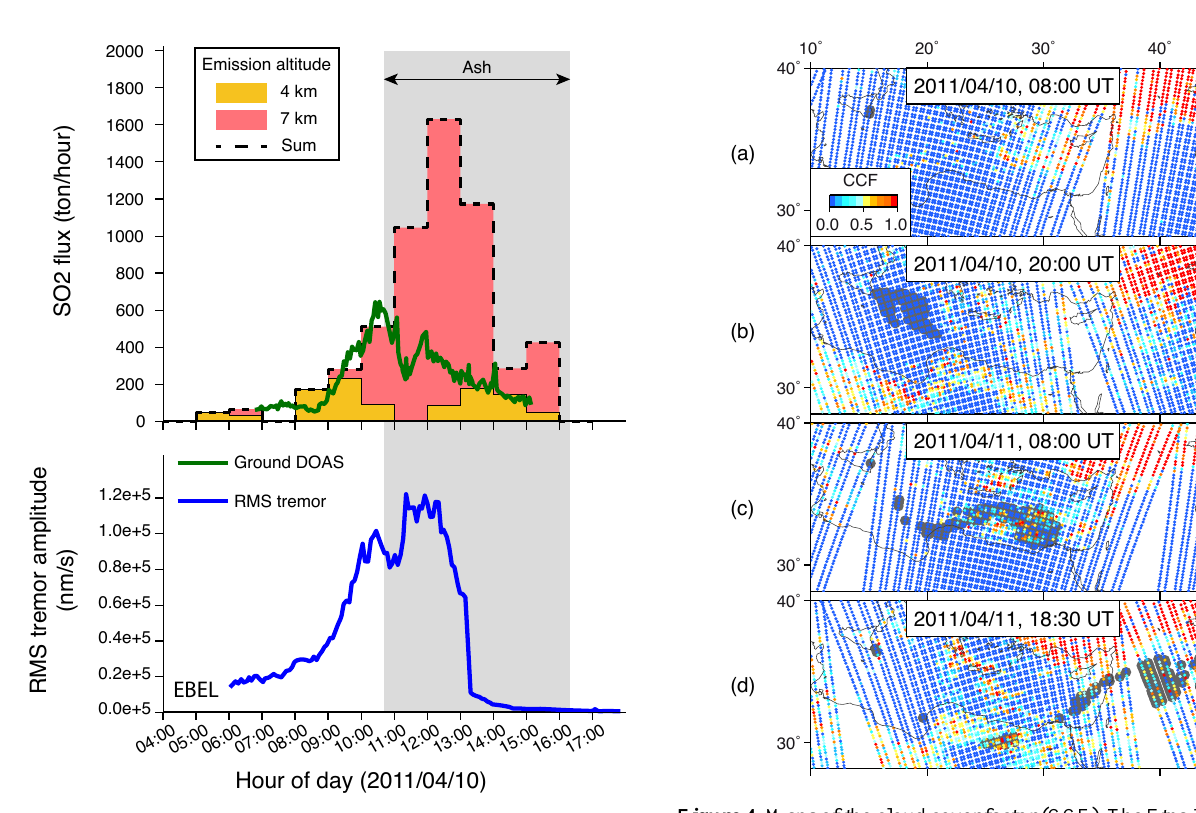
Figure 3. Etna emissions during the 10 April 2011 eruption. (Top) Temporal evolution of the SO 2 flux (th − 1 ) measured from ground- based UV-DOAS observations during daylight hours (from Bonac- corso et al., 2011; green line) and retrieved using the inversion pro- cedure which assimilated IASI SO 2 column amount observations (histograms). Yellow and pink areas indicate the proportion of the flux emitted at 4 and 7kma . s . l respectively. The dashed envelope corresponds to the total flux. The grey zone indicates presence of ash (Bonaccorso et al., 2011). (Bottom) Root mean square ampli- tude of the seismic tremor (0.5–5Hz) recorded at the station closest to the south-east Crater where the eruption took place (from Bonac- corso et al., 2011).